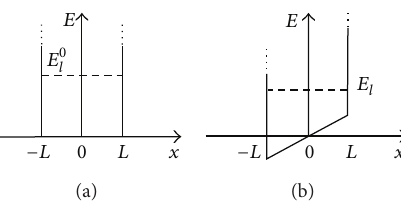
Figure 2: The infinite square potential well (a) with and (b) without the 𝐸 -field